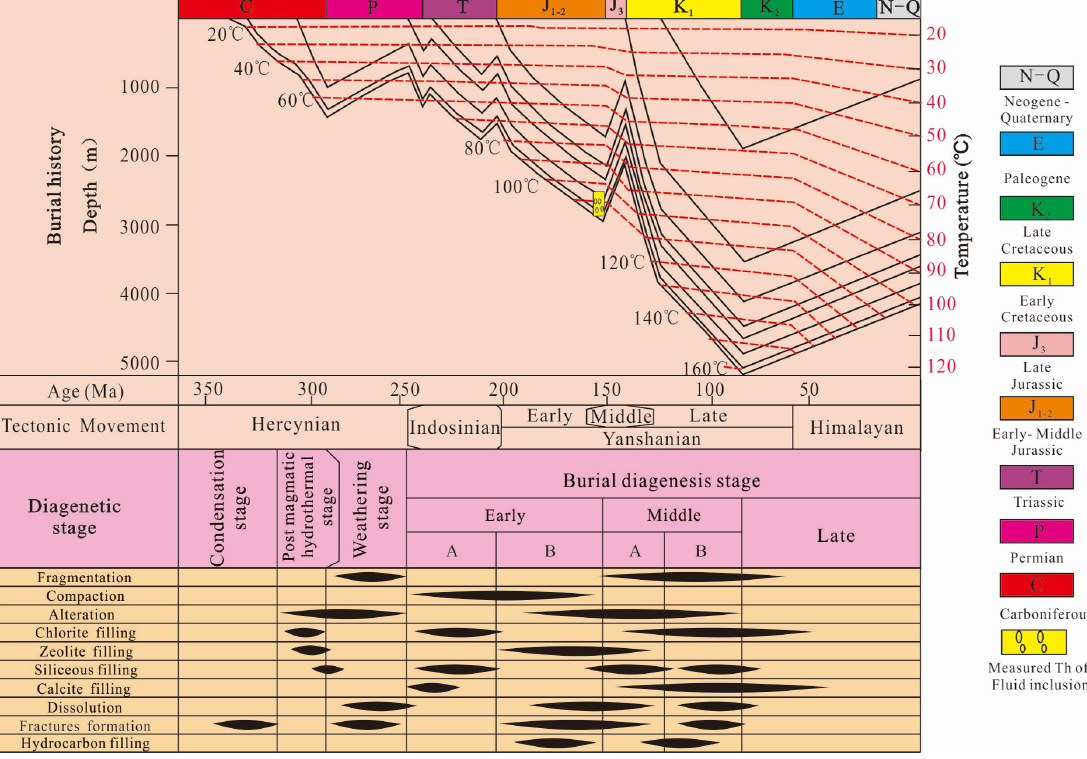
Figure 8. Burial-thermal history and diagenetic evolution of the Carboniferous Batamayineishan Formation for Dixi Area